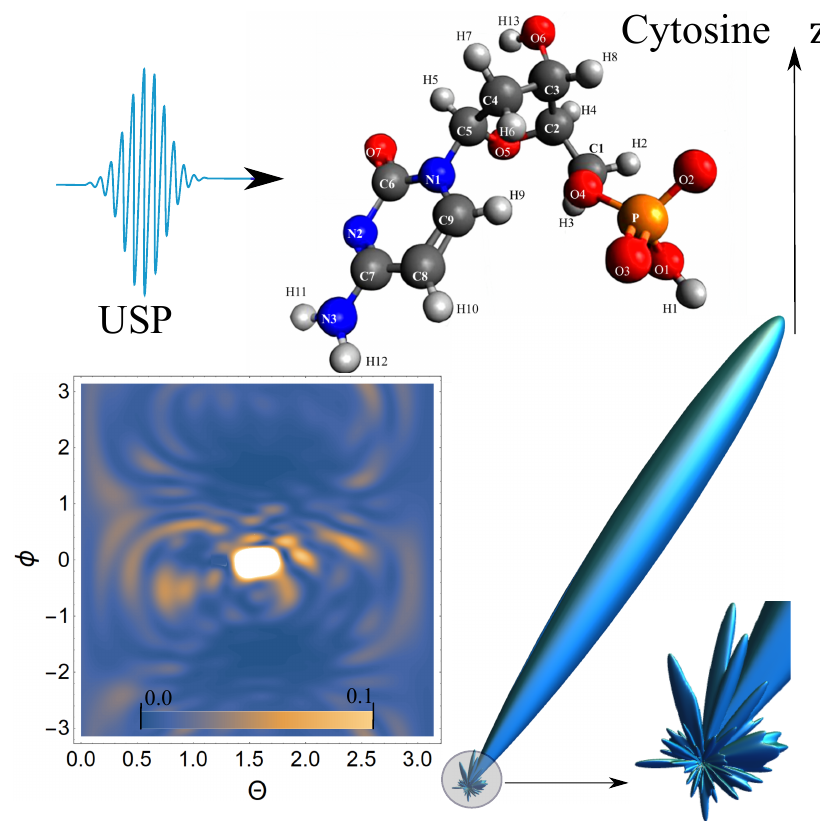
Figure 5. The scattering spectra of USP on cytosine are presented. The rest is similar to Figure